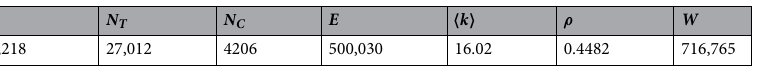
Table 1. Main properties of the Politics network: number of users N , divided in Trump/Clinton supporters N T / N C , number of links E , average degree (cid:31) k (cid:30) , reciprocity ρ (fraction of bidirectional links over the total), and total number of interactions W